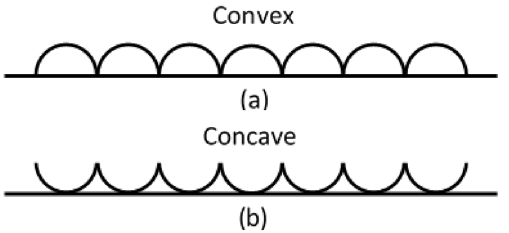
Figure 3. (a) Convex structure on enamel surface corresponding to Fig. 2a. (b) Concave structure on enamel surface corresponding to Fig. 2d. The rougher enamel surface is expected for FV in the concave case than the convex